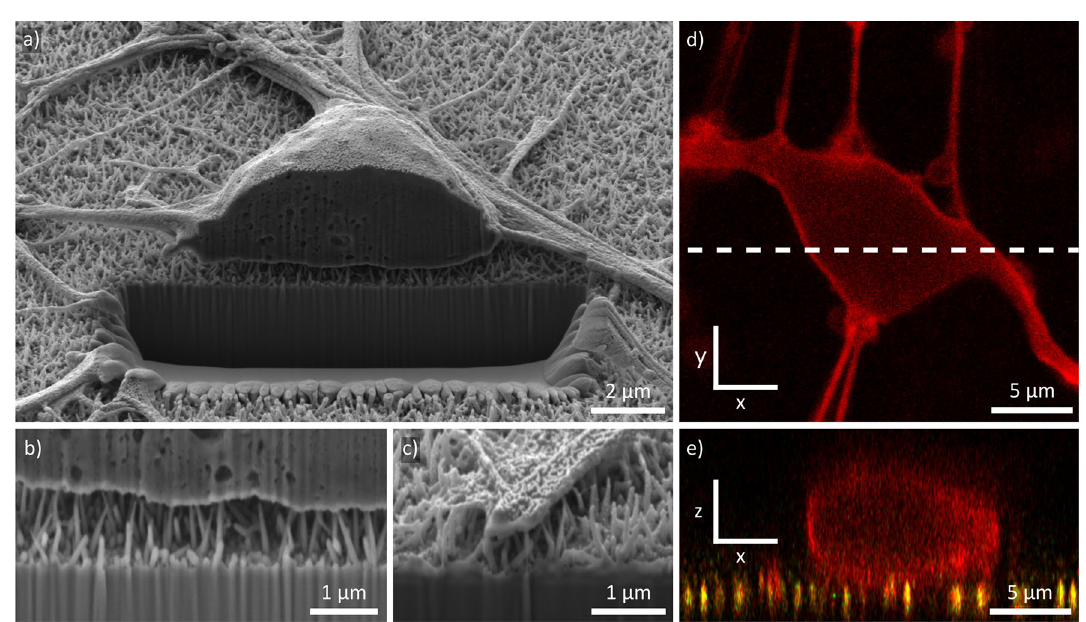
Figure 2. Cross sections prepared by FIB milling and CLSM. ( a ) Cross-sectional SEM image of the cell soma prepared by FIB milling. Tilt is 54°. ( b , c ) Close-up SEM images of the NW/cell membrane and NW/neurite interface, respectively. Both cell and neurite are hovering in a fakir like state on the NW tips. The distance to the substrate bottom is approx. 1 µm–the mean length of the NWs. Tilt is 54°. ( d ) Top view of the cell soma imaged via CLSM. The cell membrane is false colored in red. The dashed line indicates the position of the cross section in ( e ). ( e ) Cross section of the cell soma (red) in the x-z plane reconstructed from z-stacks prepared by CLSM. The NW tips’ reflections are false colored in yellow and are in direct contact with the cell